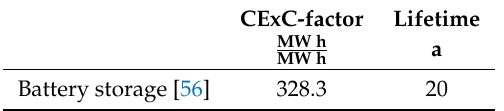
Table A2. CExC-factor and lifetime for the Li-ion battery.